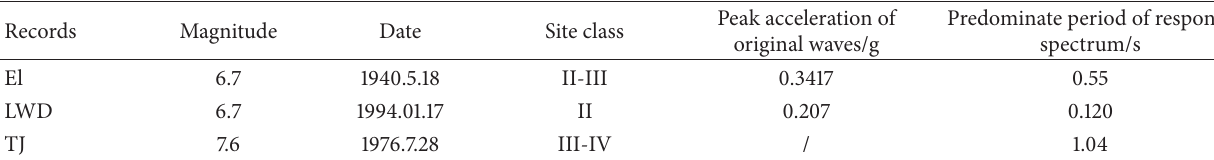
Figure 10: Arrangement diagram of sensors: (a) acceleration sensors; (b) three-directional force sensors. Table 9: Parameters of original ground motions selected.